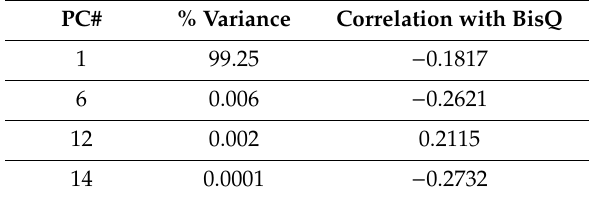
Table 4. HRV PCA eigenvalues and corresponding correlations with BisQ.